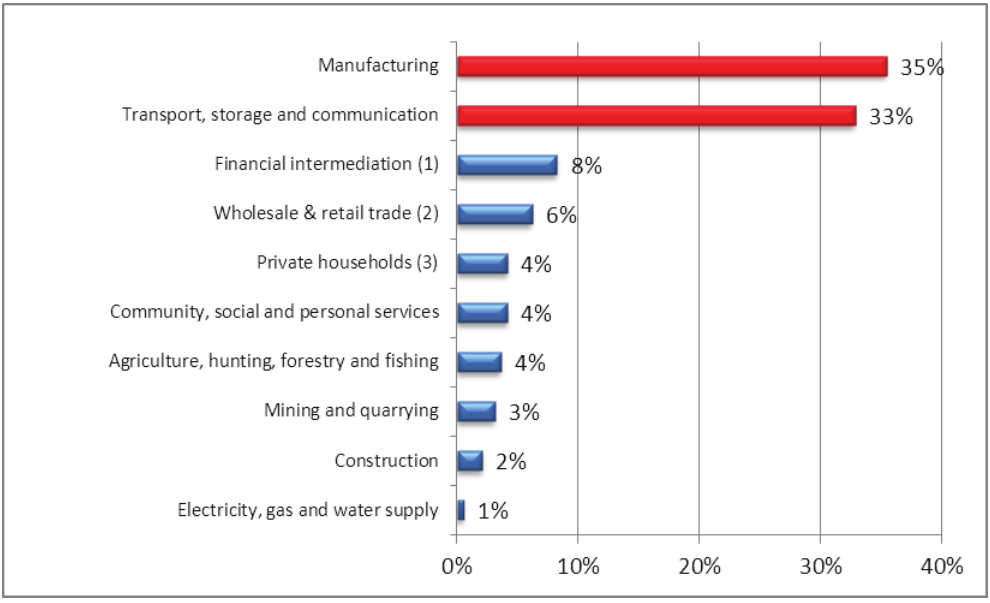
Figure 1: Industry represented by respondents